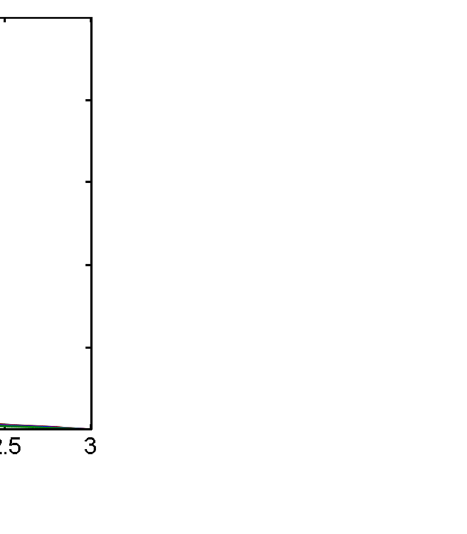
Figure 13. g (η) for various estimates of n 1